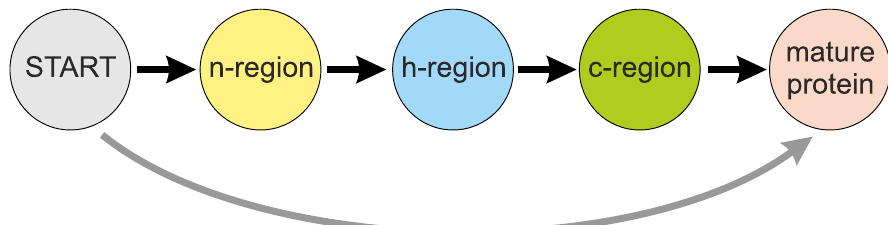
Figure 9. Diagram of signalHsmm showing hidden states which represent the SP regions and mature protein. Arrows indicate transitions between these